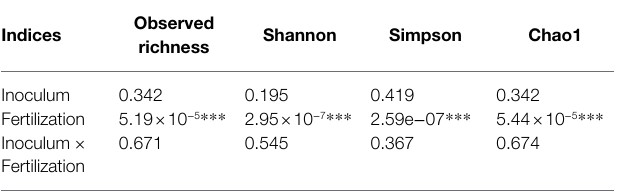
TABLE 1 | Value of p for alpha diversity metrics comparing inoculum concentration and mineral fertilization levels: observed richness, Shannon index, Simpson index and Chao1